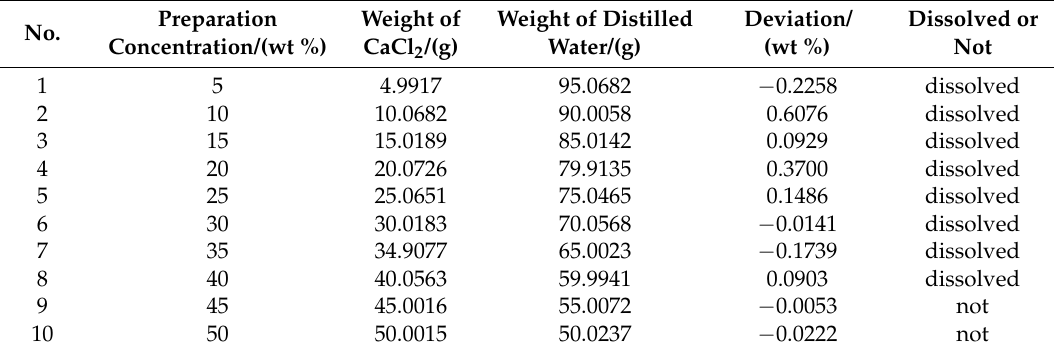
Table 2. Conditions of preparing CaCl 2